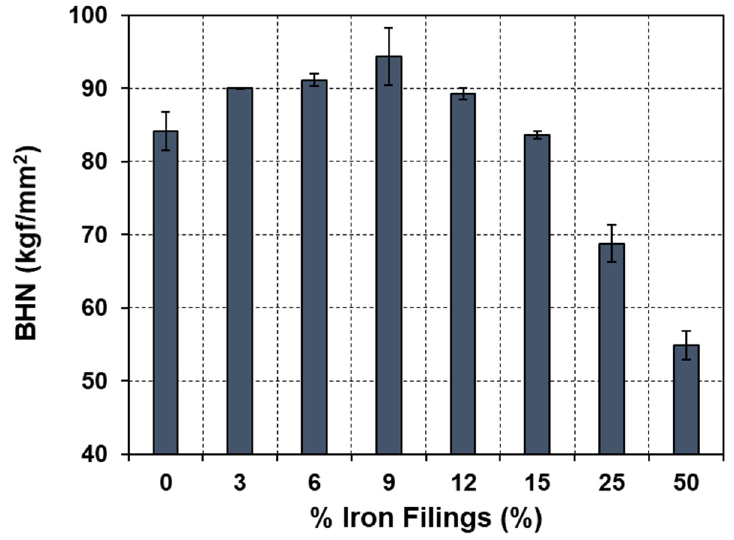
Figure 3. Brinell Hardness Number (BHN) values of the GFRE composites upon the addition of different WIF amounts.